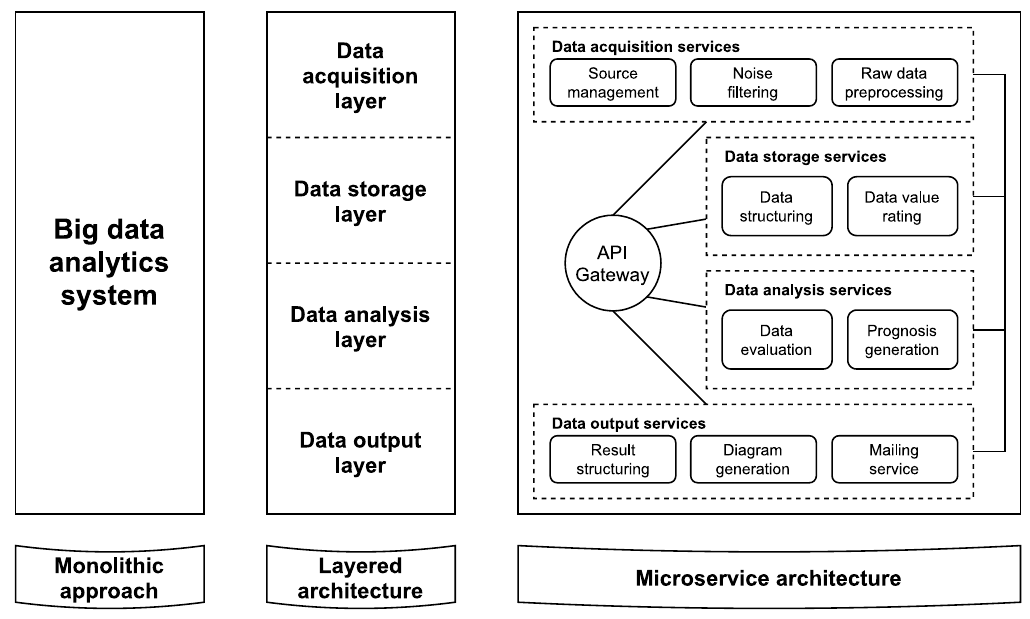
Figure 9. Illustrative division of a monolithic BDA solution into